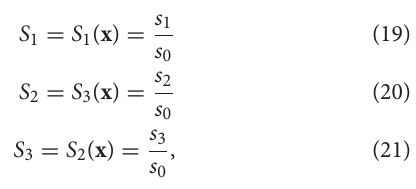
1 µ m = (cid:8) (cid:8) . | i spin ⊗ | i orbit